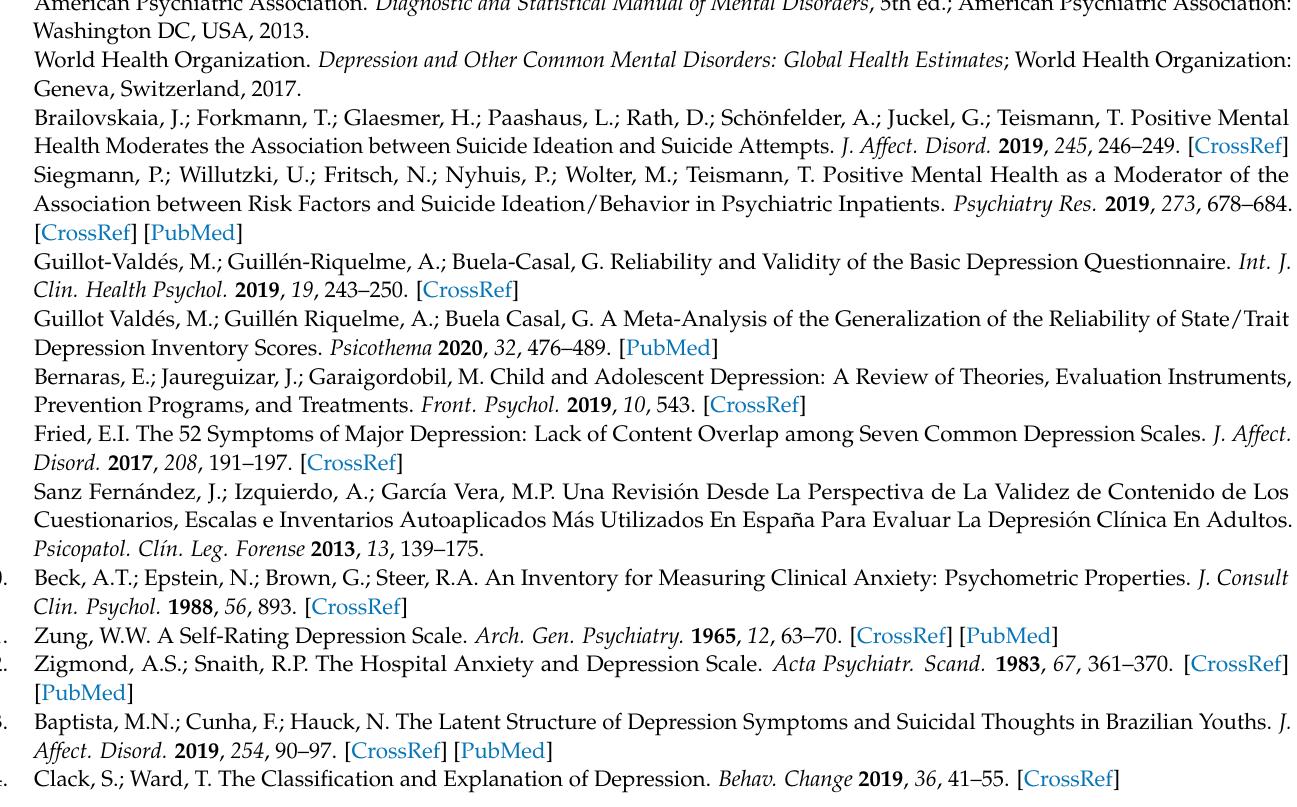
Figure A9. Stability of the ‘always’ moment network centrality indices with case dropping bootstrap subset.